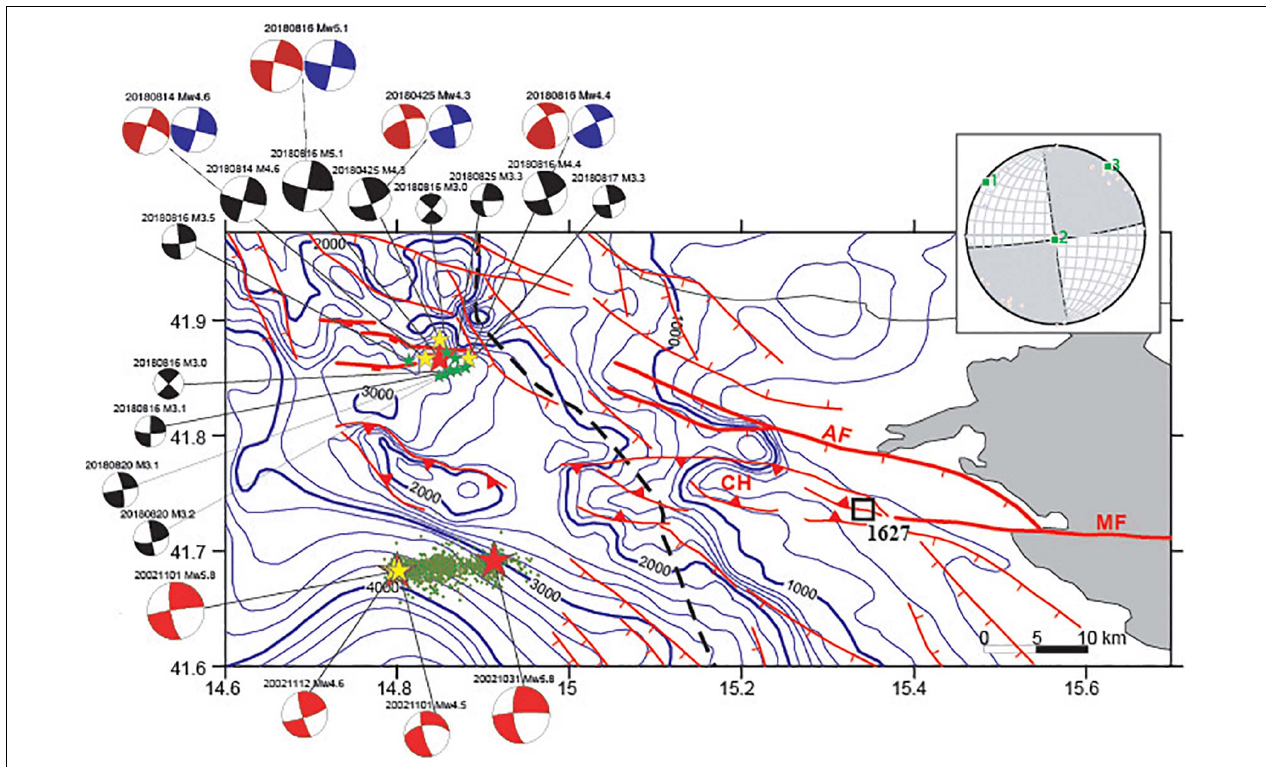
FIGURE 9 | Structural map of the Apulia Carbonate Platform in the sector between the outer Apennine belt and the western Gargano region with focal mechanisms of the mainshocks and stronger aftershocks of the 2018 Montecilfone and 2002 Molise sequences. The blue lines are isobaths (in meters) of the top of the Mesozoic–Tertiary Apulian carbonates; red lines are normal faults (or faults with prevailing dip-slip displacement) and reverse faults (modified from Nicolai and Gambini, 2007). The dashed, thick black line is the buried front of the Apennine thrust sheets. The gray area corresponds to the Mesozoic–Tertiary Apulian carbonates exposed in the Gargano region. The Mattinata Fault (MF), Apricena Fault (AF, after Patacca and Scandone, 2004), and the W–E trending faults associated with the Montecilfone sequence are outlined with thick red lines. The black square is the macroseismic epicenter of the 1627, Me6.7, Capitanata earthquake. Black beach balls of the Montecilfone events are from this study; hypocenter locations of the Molise 2002 events are from Chiarabba et al. (2005a). Red stars, M w > 5.0 earthquake; yellow stars, M w ≥ 4.0 earthquakes; green stars, M w ≥ 3.0 earthquakes. The box of the Montecilfone area in the Italian region is reported in Figure 3 . The average focal mechanism attitude (unweighted moment tensor analysis; Kassaras and Kapetanidis, 2018) has been calculated considering M ≥ 3.0 events. Red focal mechanisms are from RCMT (rcmt2.bo.ingv.it/); blue focal mechanisms are from TDMT